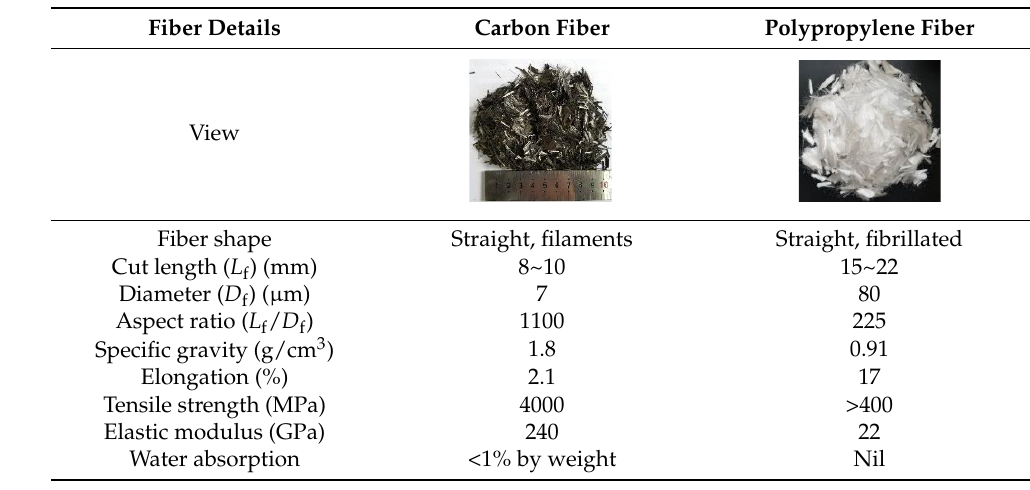
Table 2. Properties of fibers.